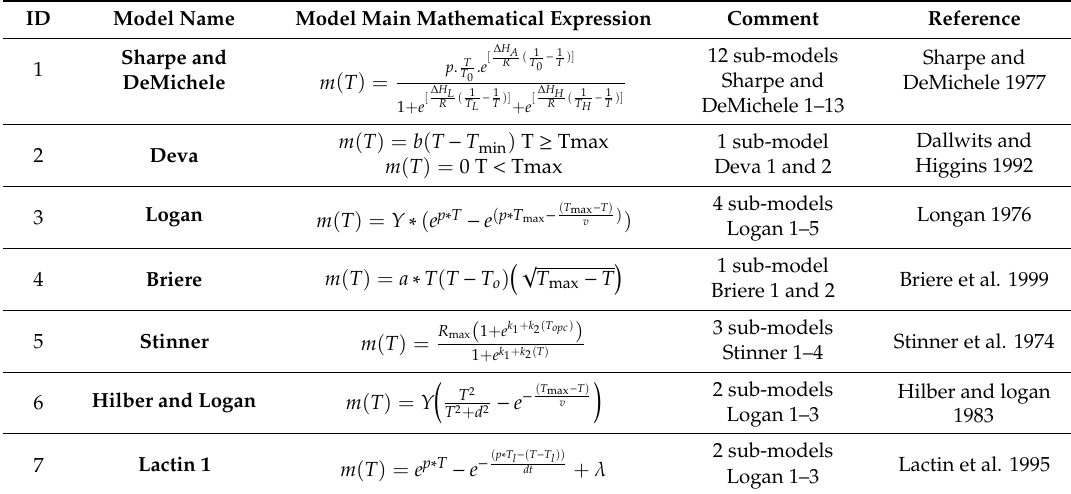
Table 1. Summary of key functions used for fitting. The “Name” column gives the name of the model, the “Equation” column gives the mathematical expression of the model, the “comment” column gives the number of derived sub-models from the original main model, and the last column gives the reference for the model. T is the independent variable, and m(T) represents the virulence model.